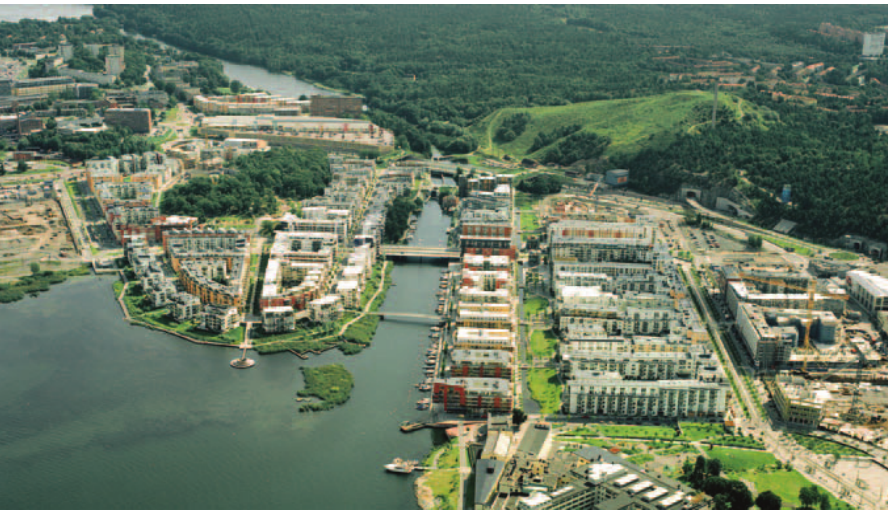
Figure 5: Hammarby Sjöstad,